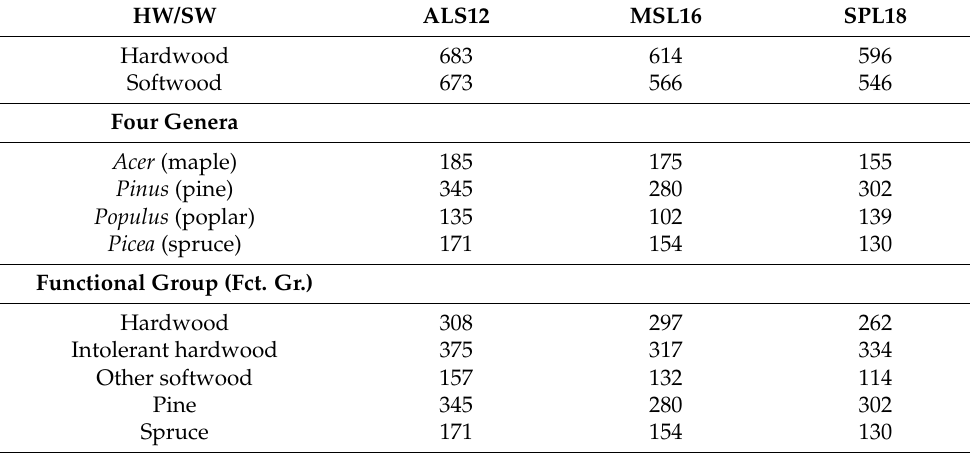
Table 5. Training crown